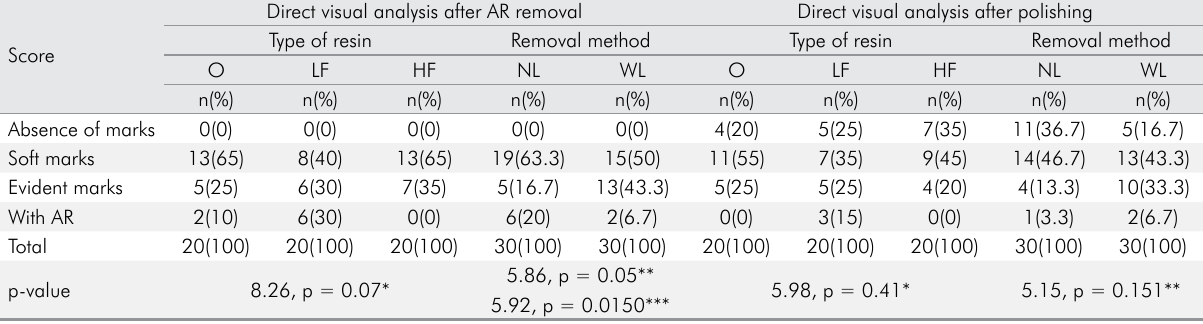
Table 1. Direct visual analysis after the removal of adhesive remnants (AR) and after polishing, considering the different systems tested (O: Opaque; LF: low fluorescence; HF: high fluorescence) and the methods for removing AR (NL: no UV light; WL: With UV light). Direct visual analysis after AR removal Direct visual analysis after Score